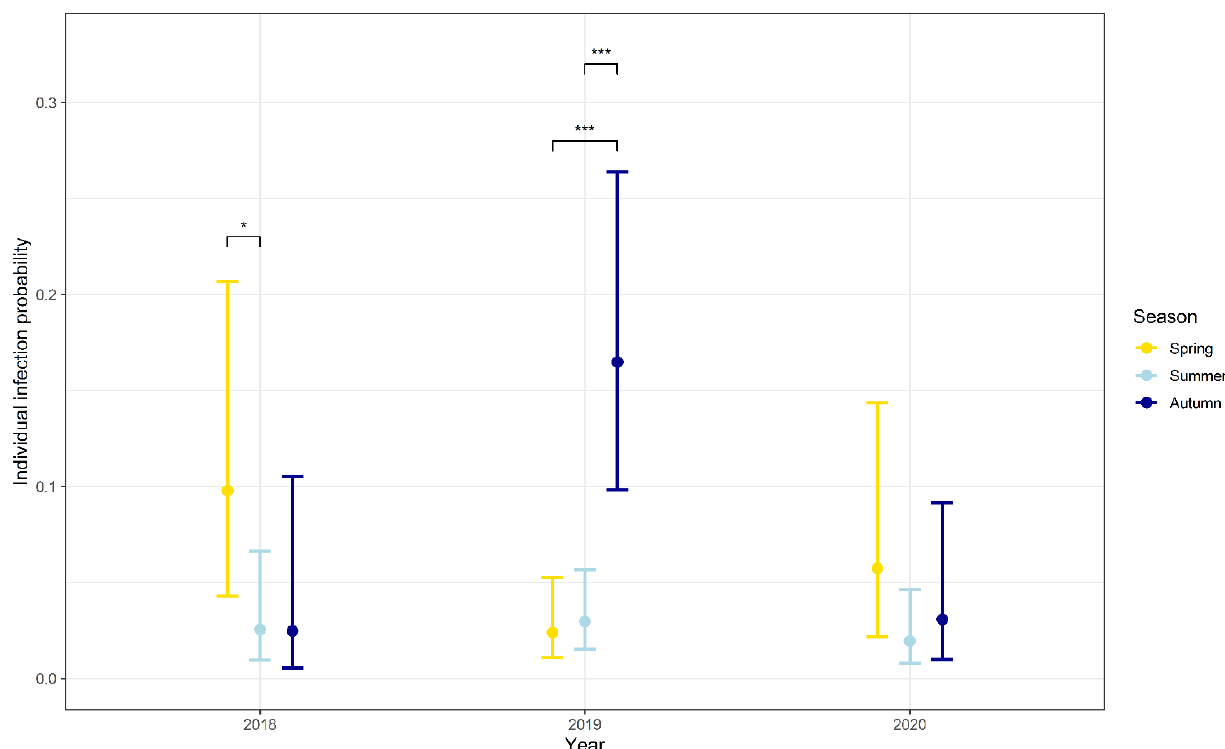
Figure 2. Potential influence of season on the individual infection probability in the years 2018 to 2020. Results are based on lipl32 -qPCR-positive animals, significant differences between seasons are highlighted by stars: * = significant ( p < 0.05), *** = highly significant ( p < 0.001). Table 2. Results of generalized linear mixed modelling with binomial error distribution showing the influence of season, year and their interaction on the individual infection probability.